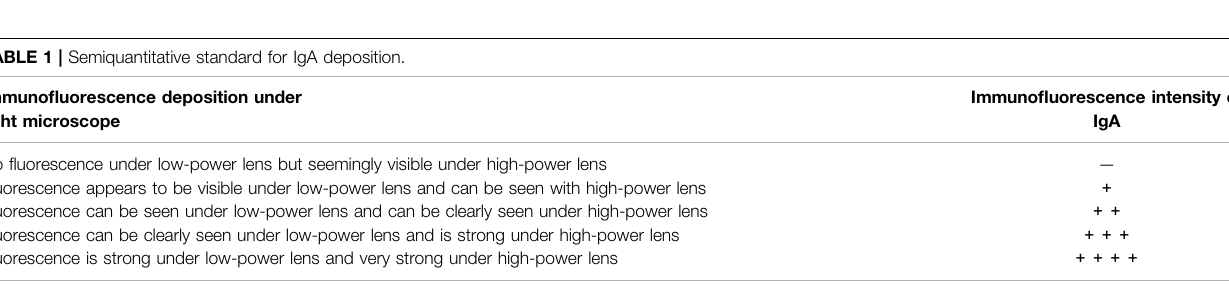
TABLE 1 | Semiquantitative standard for IgA